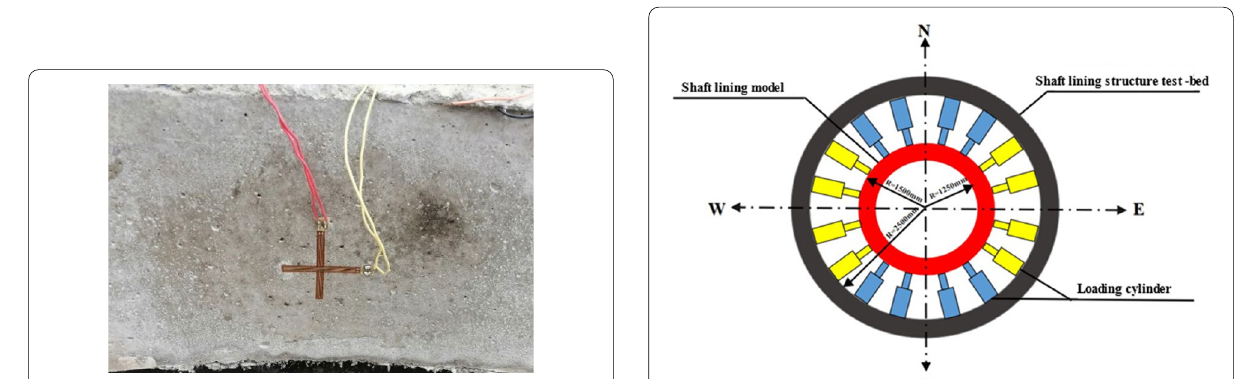
Fig. 10 Strain gauges installed on the concrete at the inner edge of the shaft wall.